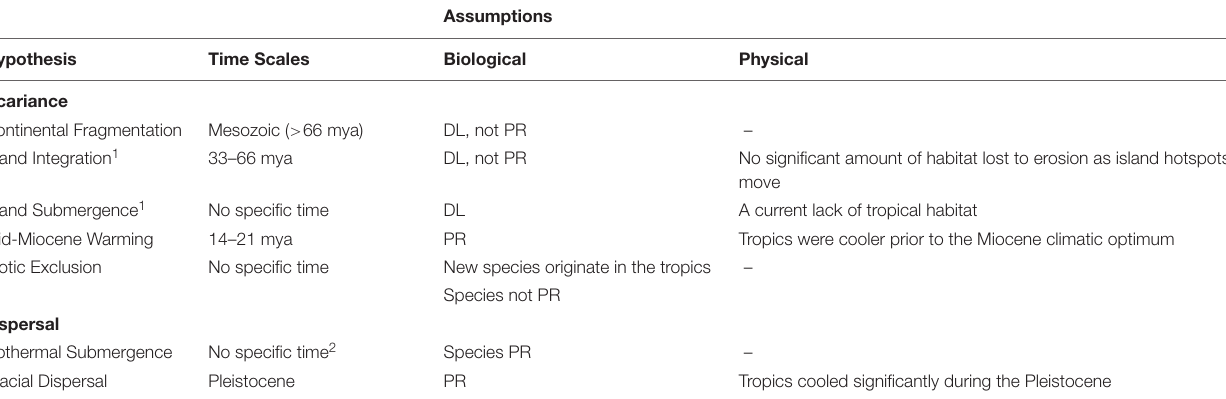
TABLE 2 | Proposed hypotheses associated with the formation of anti-tropical distributions.